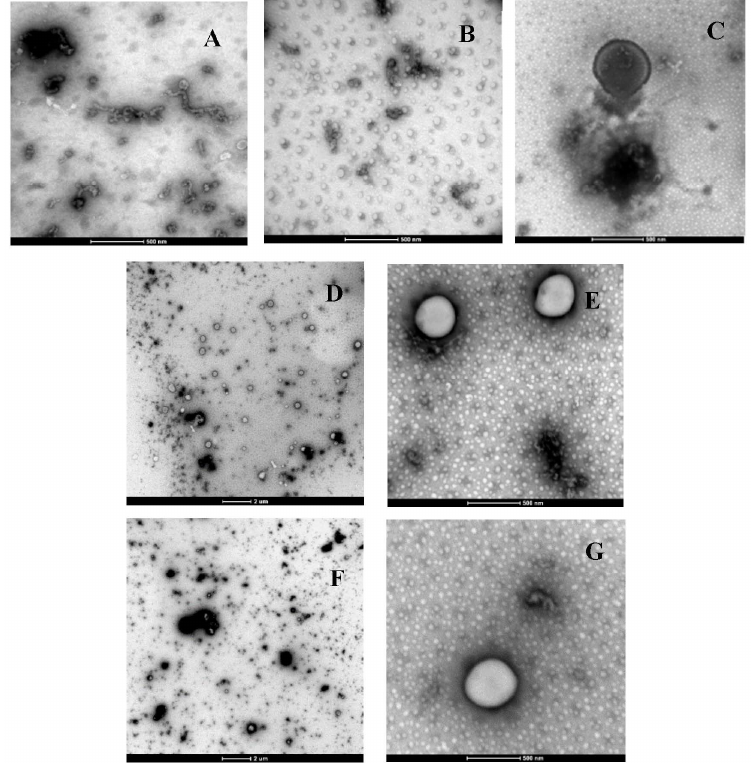
Figure 2. Transmission electron micrographs of the kiwifruit juice fortified with ( A ) no liposomes, ( B ) free green tea waste extract (GTWE), ( C ) empty liposomes, ( D , E ) GTWE-loaded single layer liposomes (SLLs) without pasteurisation, and ( E , F ) GTWE-loaded SLLs with pasteurisation. Magnifi- cation: 6000× for ( D , F ) and 43,000× for ( A – C , E , G ).